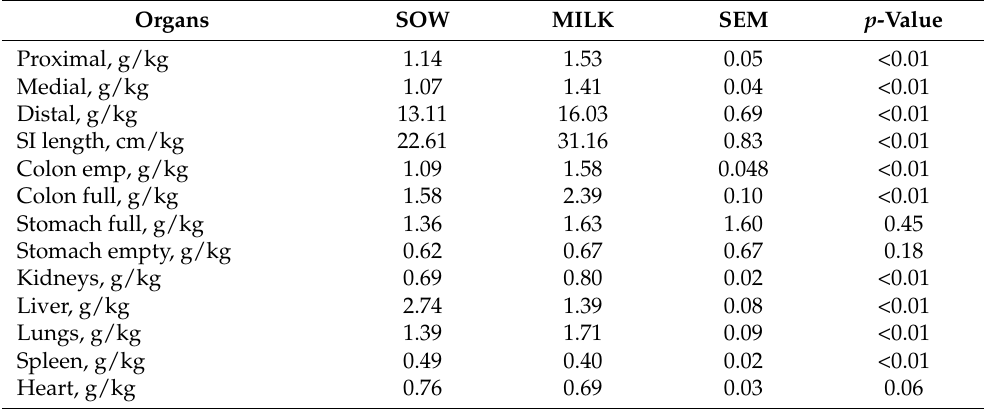
Table 4. Length of small intestine and organ weights of sow (SOW) and artificially (MILK) reared piglets presented as relative organ weights (g/kg) with standard error of the means (SEM). Organs SOW MILK